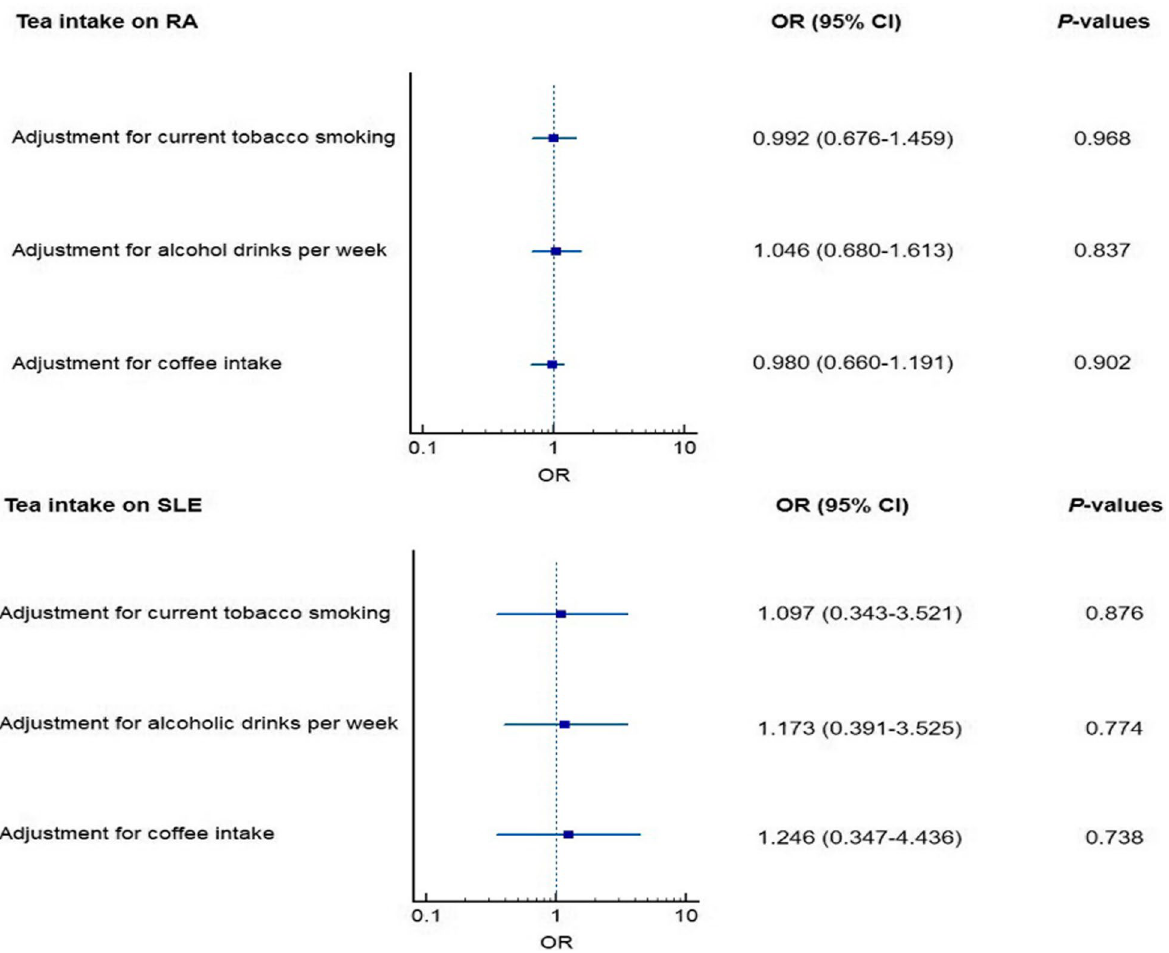
Fig. 2 Multivariable Mendelian randomization analyses for the association of genetically instrumented tea intake with RA and SLE. CI, confidence interval; OR, odds ratio; RA, rheumatoid arthritis; SLE, systemic lupus